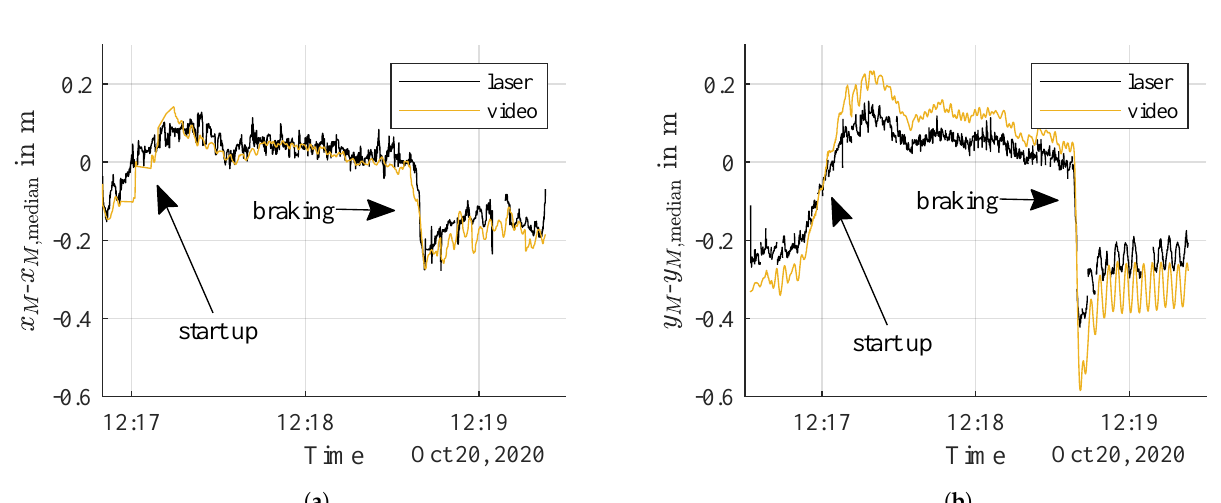
Figure 11. Tower movement in the lateral and axial direction measured by the laser scanner in the horizontal alignment and video recording during start-up and braking. ( a ) Tower movement in the lateral direction ( x M ). ( b ) Tower movement in the axial direction ( y M